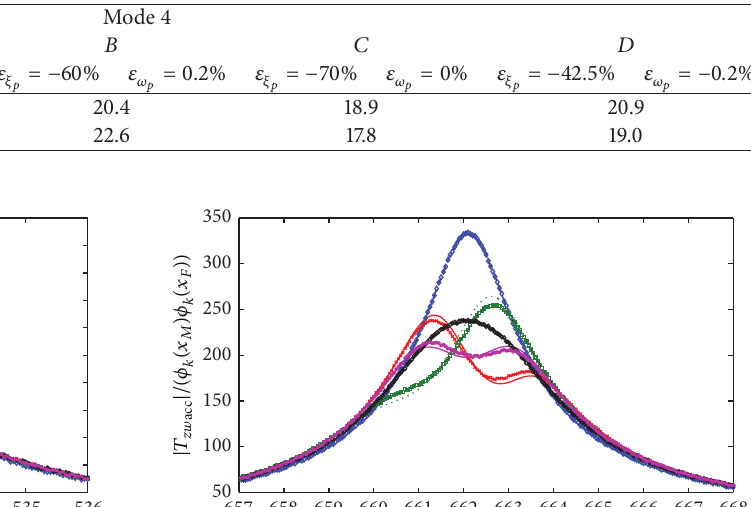
Table 9: Test cases for Mode 4.